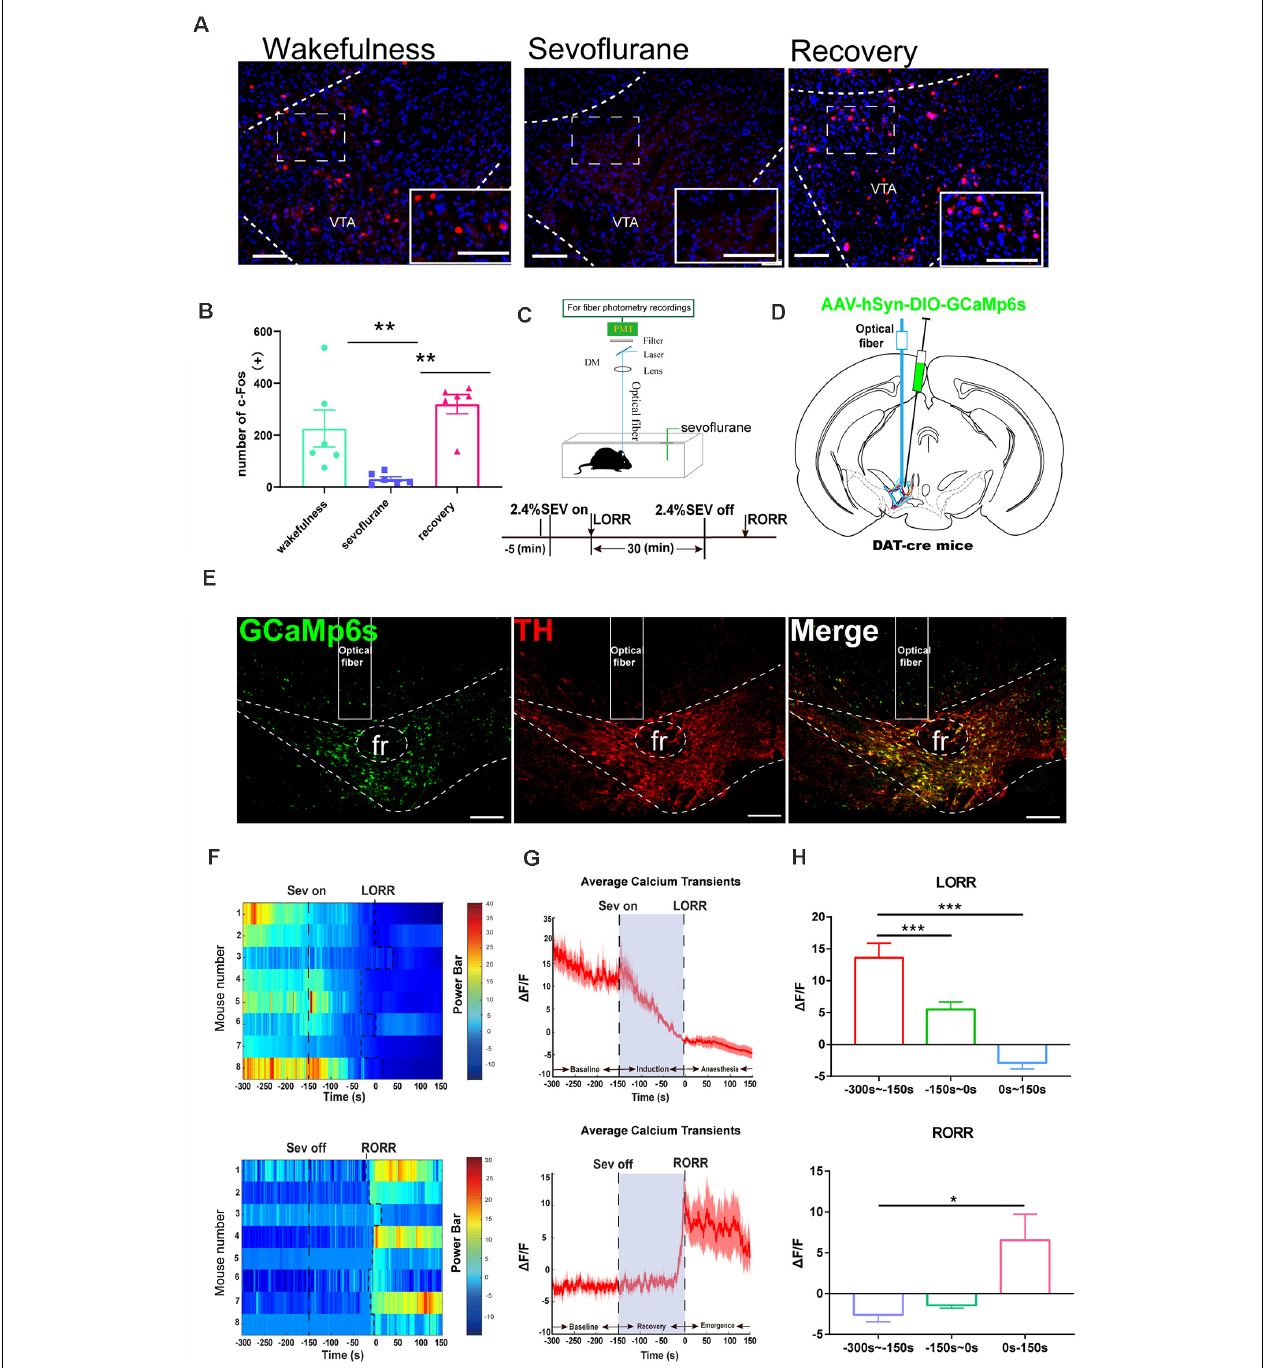
FIGURE 1 | Ventral tegmental area (VTA)-dopamine (DA) activity and neural dynamics in response to sevoflurane. (A) Expression of c-Fos in the VTA in the wakefulness state, sevoflurane anesthesia and recovery from anesthesia in mice (Scale bars: 200 µ m). (B) Average number of c-Fos-immunopositive neurons. One-way analysis of variance (ANOVA) followed by post hoc Bonferroni’s test ( n = 6). ** p < 0.01. (C) Schematic configuration of in vivo Ca 2+ signal recording. Timeline for Ca 2+ signal recording in sevoflurane anesthesia. (D) Expression of GCaMP6s in VTA from each cases are outlined. (E) Expression of GCaMP6s in VTA-DA neurons. Viral expression (GCaMP6s, green) in the VTA and colabeling with DA neurons (TH immunofluorescence, red; Scale bars: 200 µ m). (F) Heat map illustrating changes in the Ca 2+ signals related to sevoflurane-induced LORR and RORR. (G) Average calcium transients associated with loss of righting reflex (LORR) and recovery of righting reflex (RORR) mean (red trace) ± SEM (red shading). Note that the Ca 2+ signals gradually decreased during the LORR process and increased sharply after RORR. (H) ∆ F/F represents the deviation in Ca 2+ fluorescence from the baseline, which is the averaged ∆ F/F between t = –300 s and –150 s. Data are presented as the mean ± SEM. * p < 0.05; ** p < 0.01; *** p < 0.001, n = 8, by paired t -test.